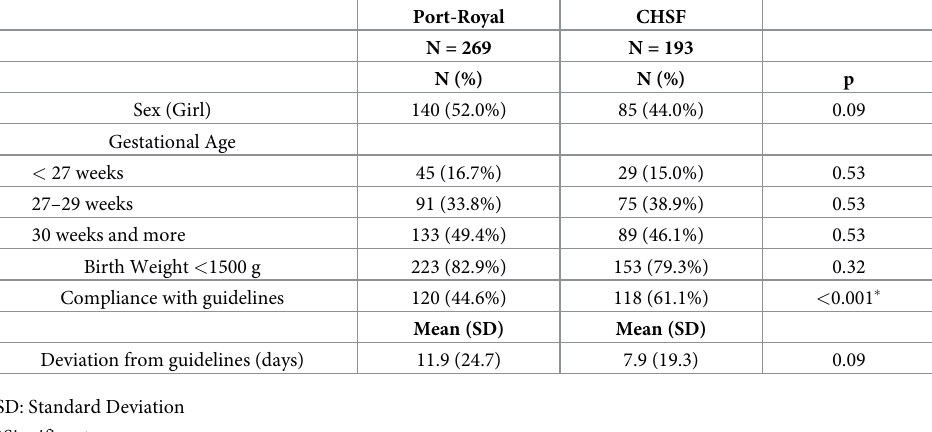
Table 4. Infants characteristics and outcomes for effectiveness—CHSF and Port-Royal medical centers, after period.